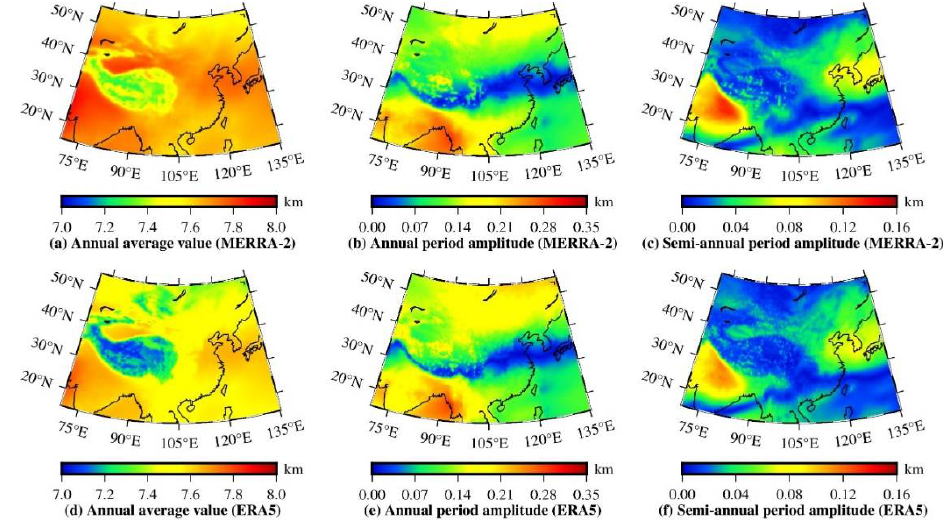
Figure 4. Distributions of the ZTD height scale factor: ( a , d ) annual mean (unit: mean value/km), ( b , e ) annual amplitude (unit: amplitude/km), and ( c , f ) semiannual amplitude (unit: amplitude/km).